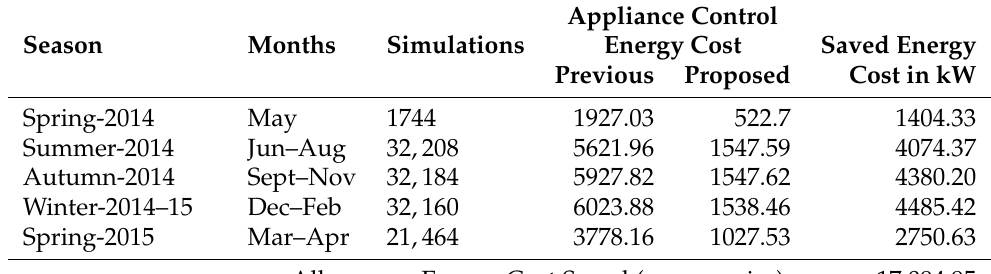
Table 10. Season-wise energy-cost comparison.